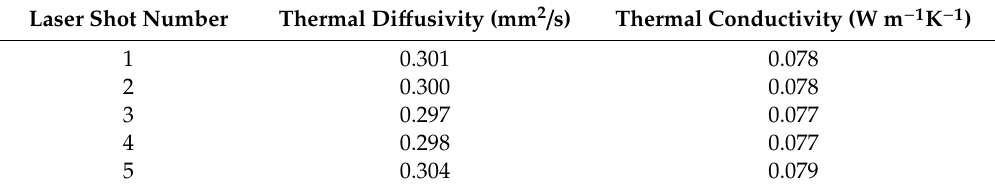
Table 4. The laser flash analysis (LFA) thermal di ff usivity and estimated thermal conductivity of LNC-MO at 675 ◦